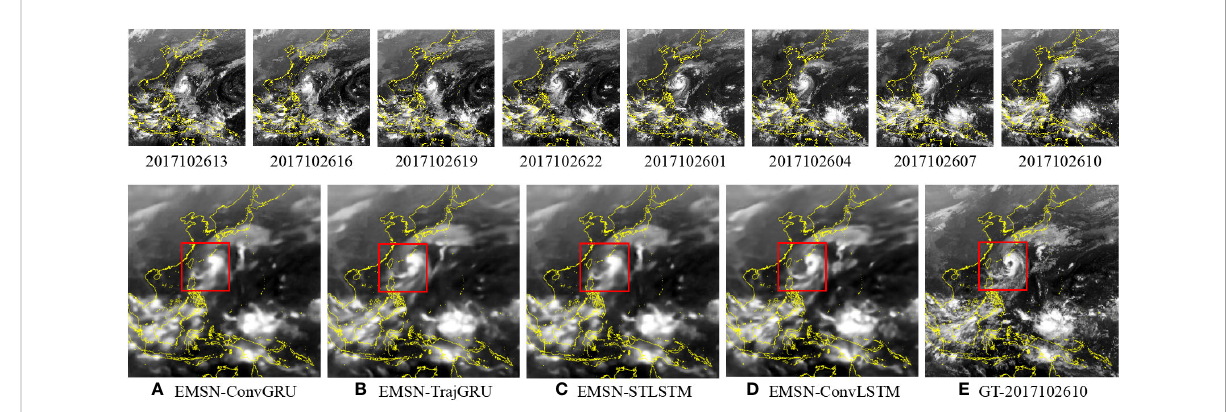
FIGURE 9 Visual results of the EMSN with different RNN structures; second-row images are the outputs. (A) EMSN-ConvGRU; (B) EMSN-TrajGRU; (C) EMSN-STLSTM; (D) EMSN-ConvLSTM; and (E) ground